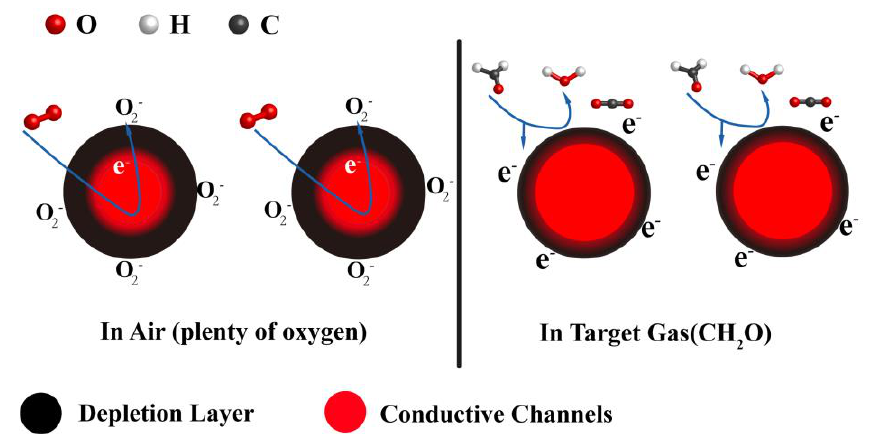
Figure 8. Schematic illustration of the sensing mechanism of MoS 2 before and after exposure to target gas.